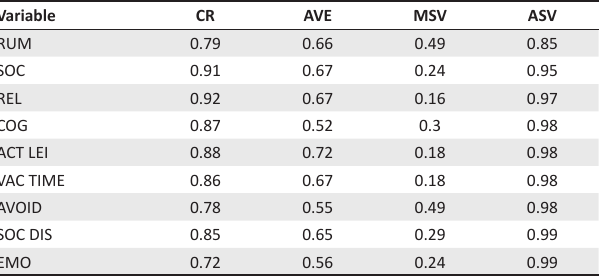
TABLE 3: Reliability and validity estimates: Revised model.